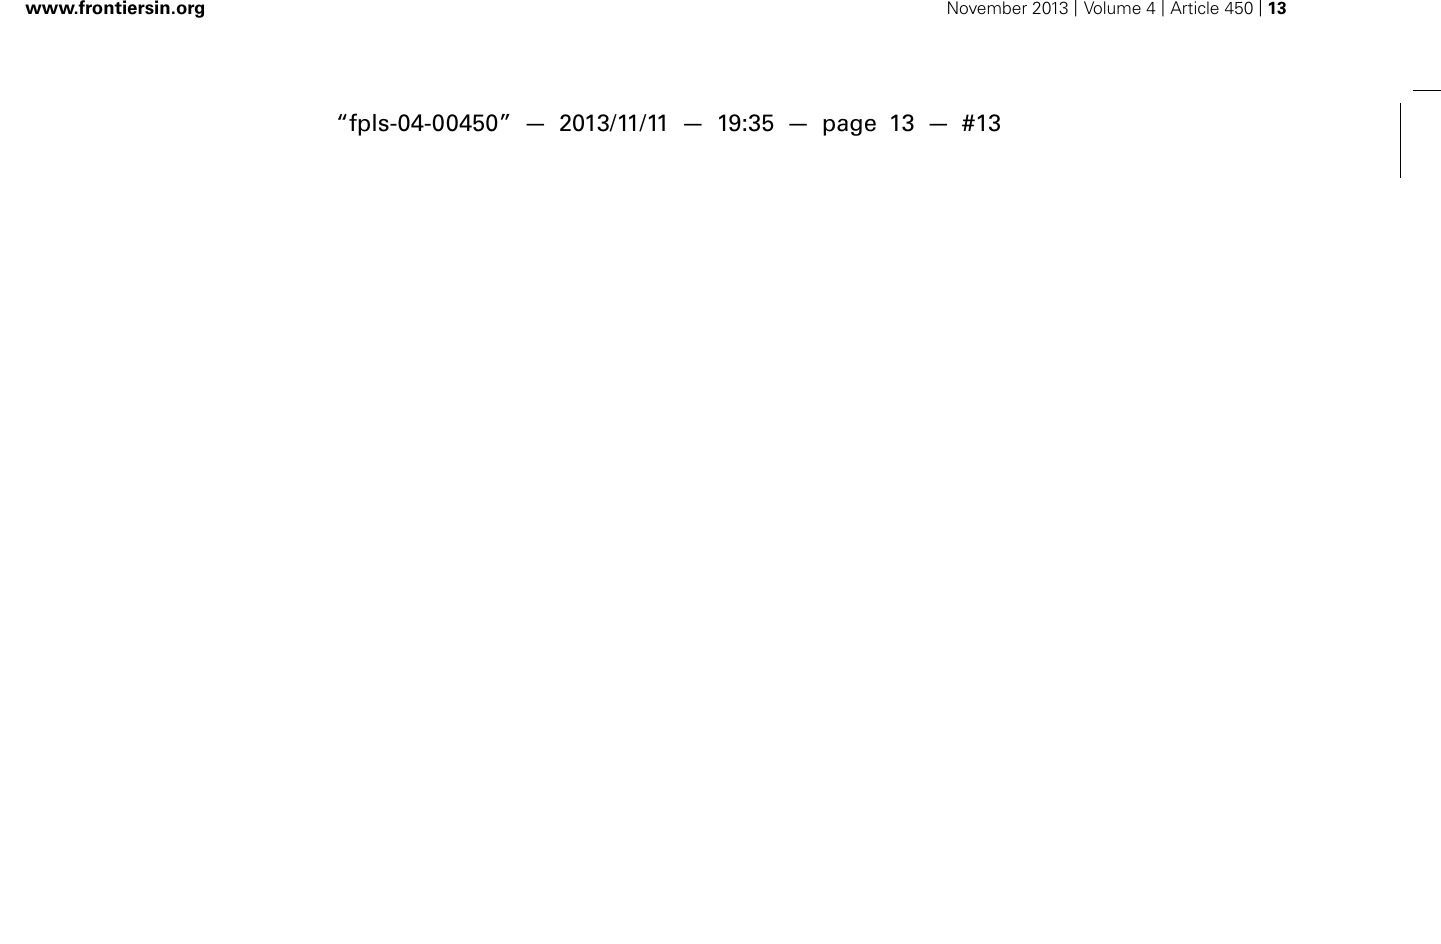
FIGURE 9 | Metabolic and non-metabolic functions of GAPC in plant cells under normal and different stress conditions. Functional roles of GAPC that have been observed in different studies and cell types are here summarized in a single hypothetical plant cell. Under normal conditions, GAPC fulfills metabolic function by participating to glycolysis (left side of the figure) while it can play non-metabolic functions under specific stress conditions (e.g., drought, salinity and cold stress, treatments in the presence of cadmium (Cd), hydrogen peroxide (H 2 O 2 ) and nitrosoglutathione (GSNO; right side of the figure). Overall, these conditions are supposed to induce